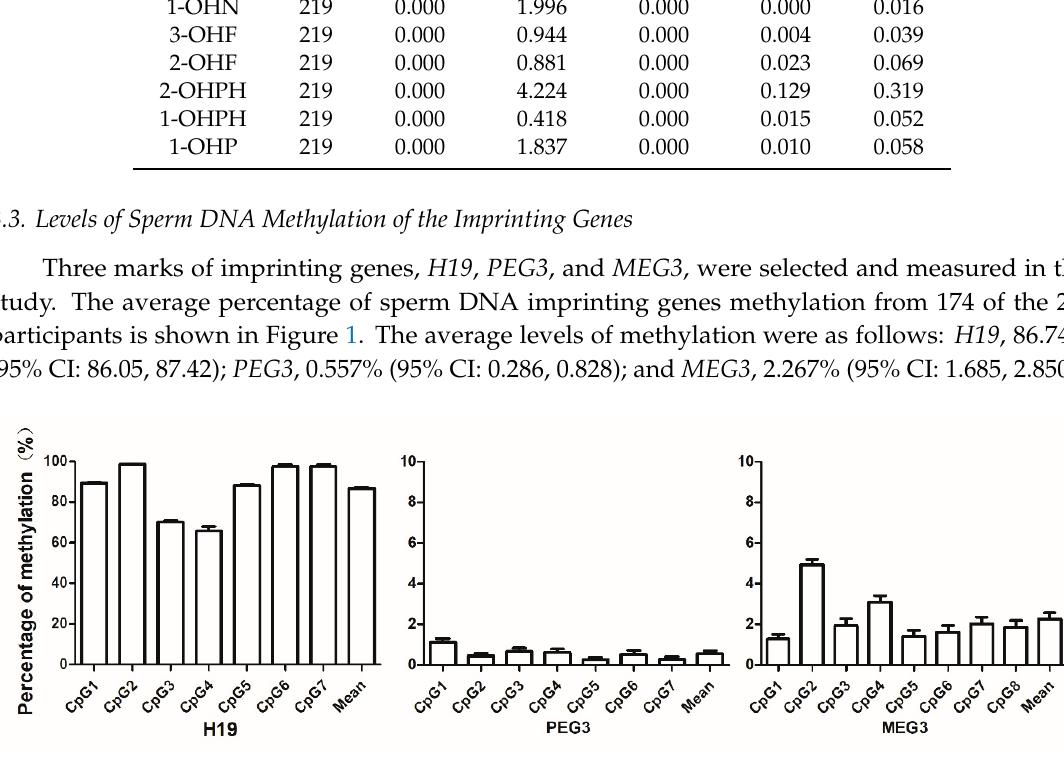
Figure 1. Levels of sperm DNA methylation at the differentially methylated regions (DMRs) of imprinting genes. The bars represent the percentage of methylated genes by individual CpG site for each DMR of the imprinting gene: H19 , Peg3 , and Meg3 . The results are the means ± SEM of 219 human sperm samples.